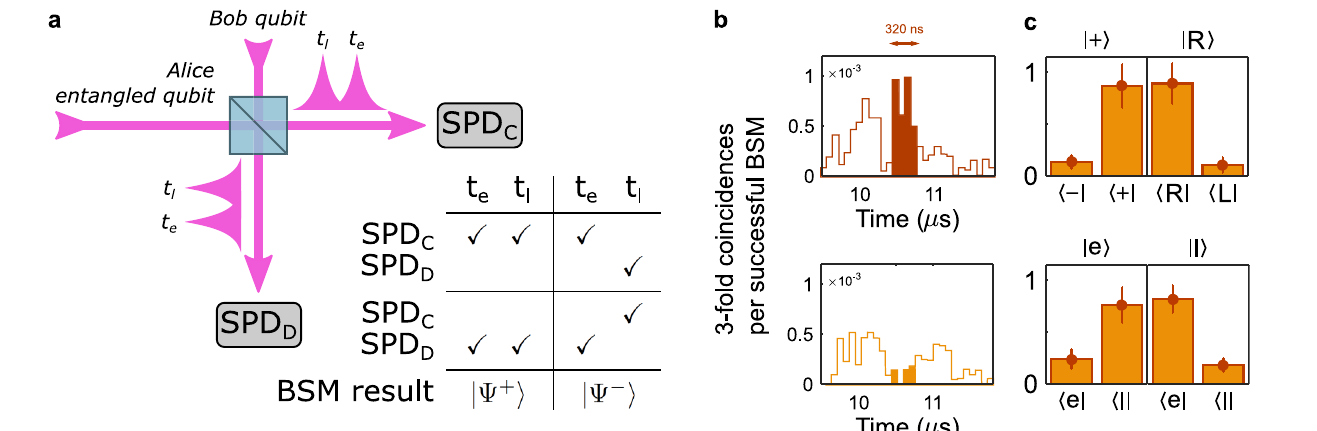
(cid:1) F (Fig. 2c),resulting in = 85(4) %, whichis signi fi cantly above the 66.7 % classical limit for single qubits 34 and the 73.6 % limit considering the statistics of the weak coherent input qubits and the ef fi ciency of the quantum channel (see Methods). The main reasons for the reduced fi delity are the limited fi delity of the shared entangled state, the fi nite indistinguishability between the entangled telecom photon and the qubit to be teleported and the fact that we encode the input qubits as weak coherent states (see Supplementary Note 3).